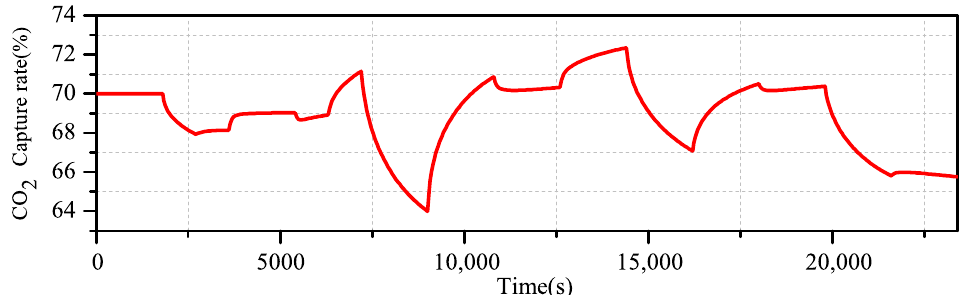
Figure 7. Actual output of the CO 2 capture system.